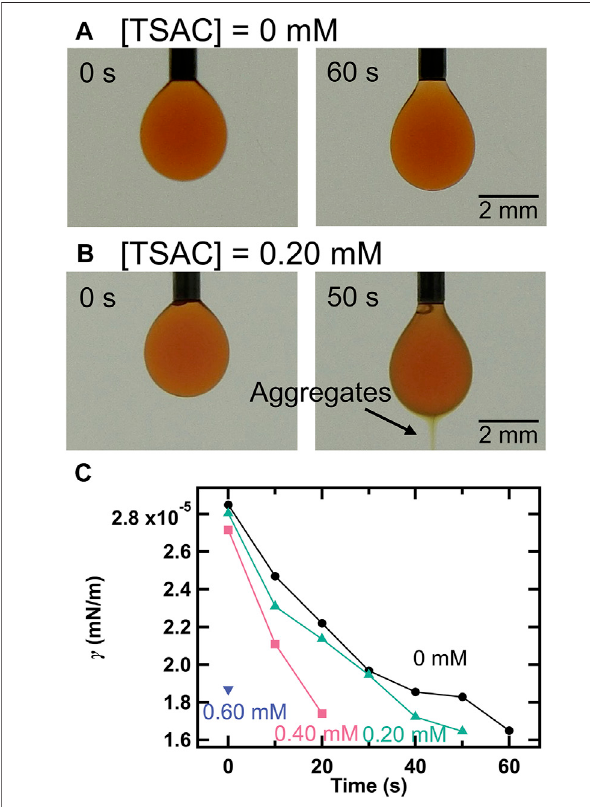
FIGURE 3 | Snapshots of the droplet at the tip of a needle when (A) [TSAC] = 0 mM and (B) [TSAC] = 0.20 mM ([DMPC] = 0.25 mg/ml and [I 2 ] = 10 mM). (C) Variation in the interfacial tension ( γ ) with time at different TSAC concentrations (the concentrations of DMPC and I 2 were the same as those in the cases of (A) and (B) ).